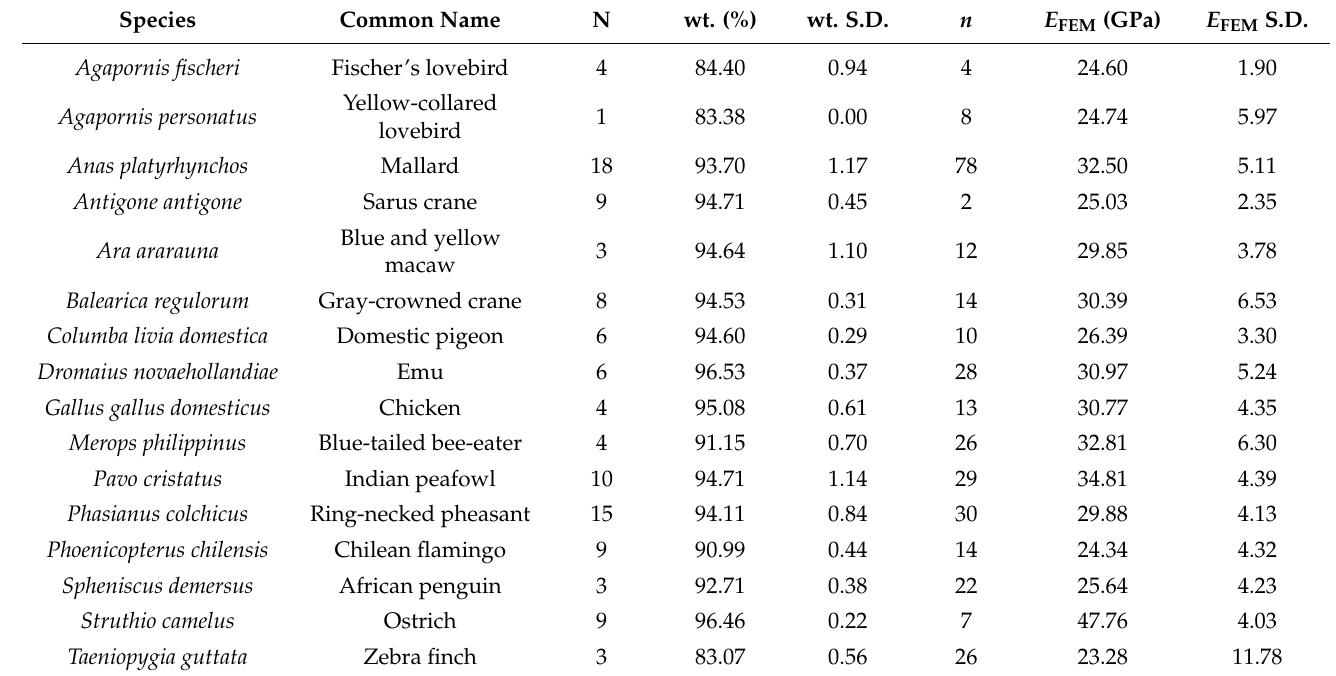
Table 1. Weight percentage of CaCO 3 obtain from acid-base titration. N: number of titrations, wt.: weight percentage of CaCO3 (%), n: number of eggs, E FEM : effective Young’s modulus (GPa), S.D.: standard